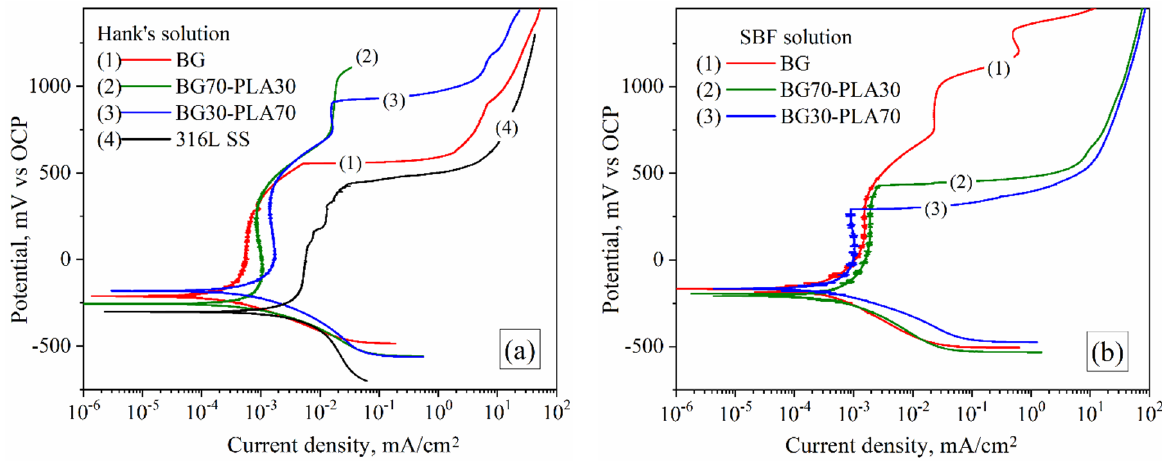
Figure 13. Potentiodynamic behaviour of both composite scaffolds in ( a ) Hank’s saline solution and ( b ) SBF.